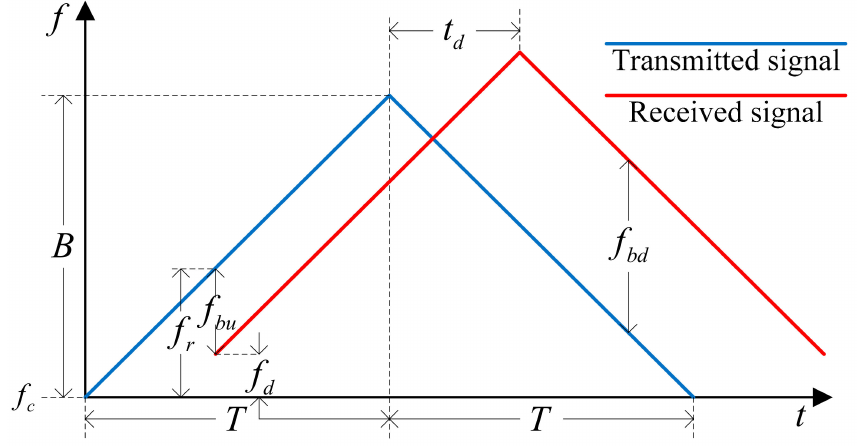
Figure 2. Basic waveform of FMCW